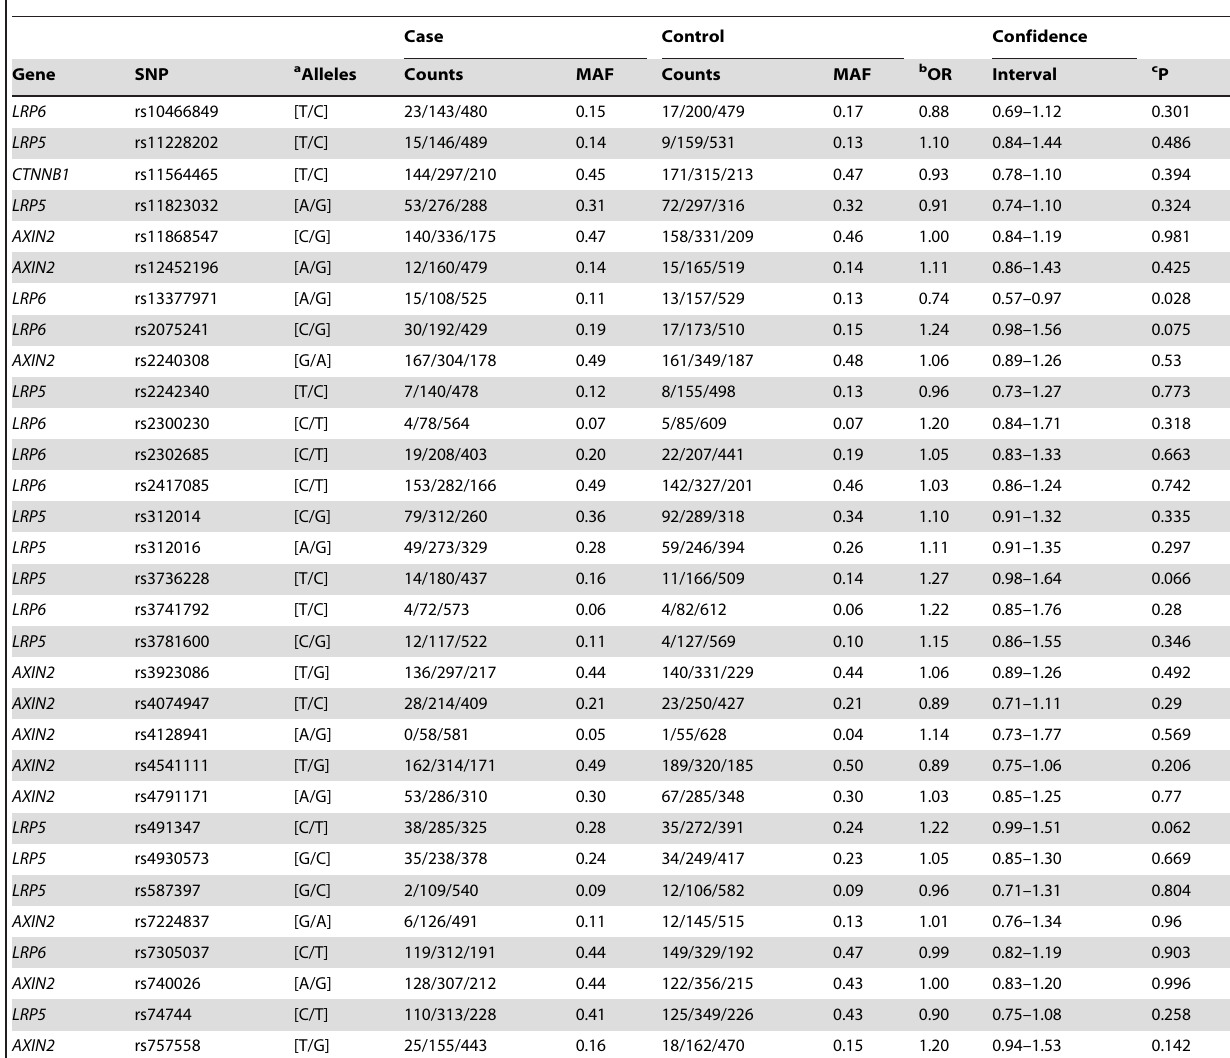
Table 2. Minor allele frequencies (MAF) and genotype counts in cases and controls.